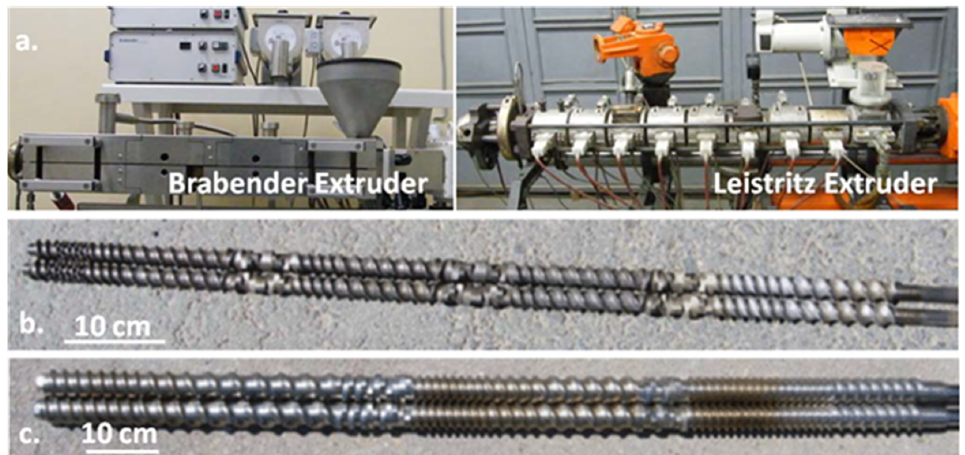
Figure 1. The lab-scale extruders used in the tests ( a ); screw profiles of the Brabender ( b ) and Leistritz ( c ) extruders.